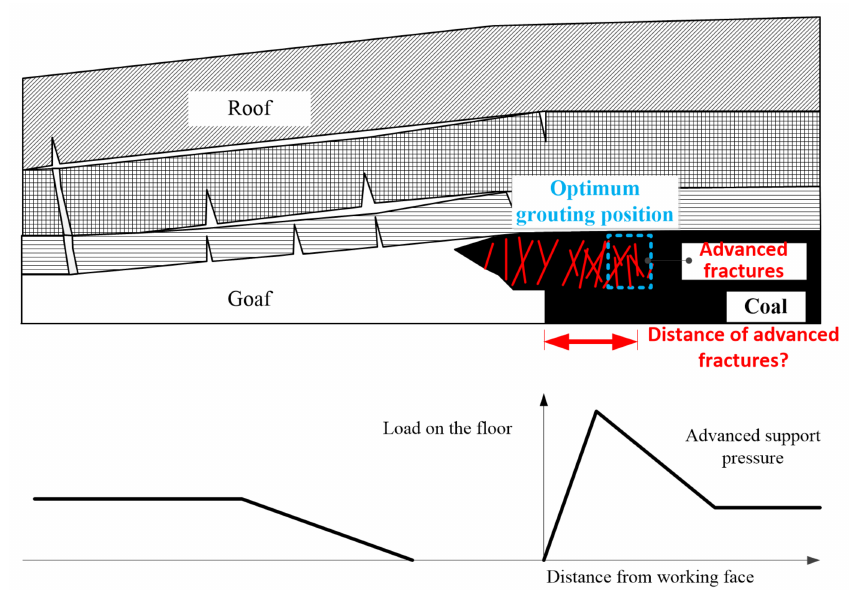
Figure 1. A schematic diagram of advanced support pressure and advanced